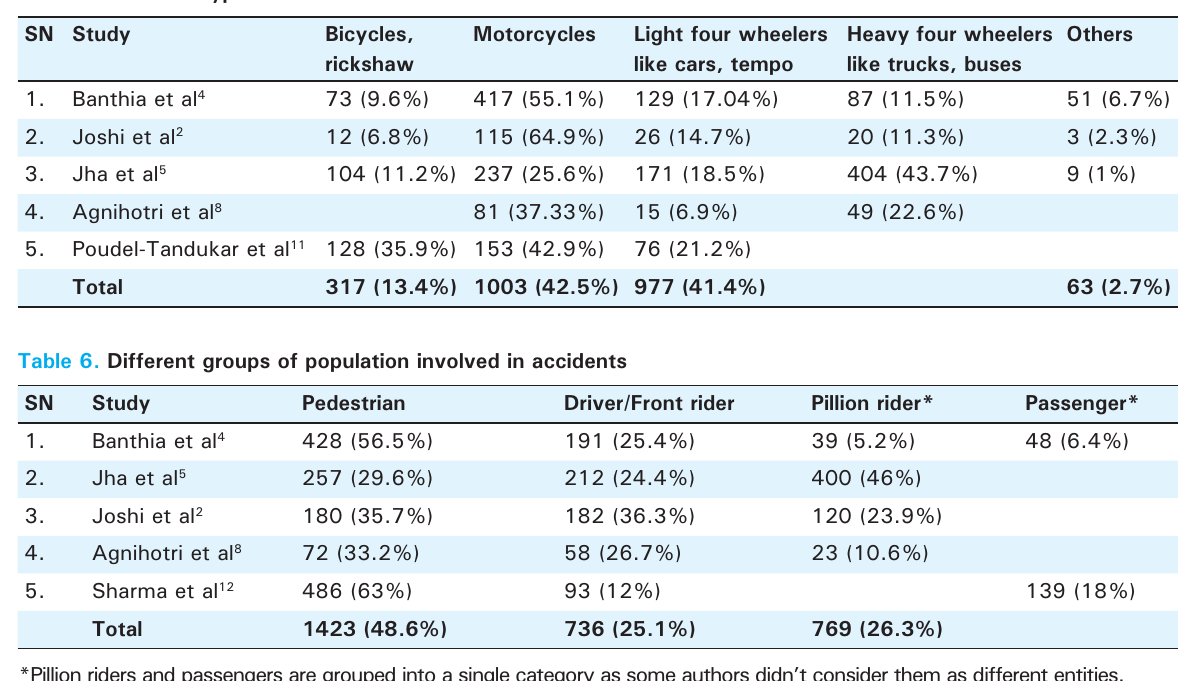
Table 5. Different types of vehicles involved in accidents